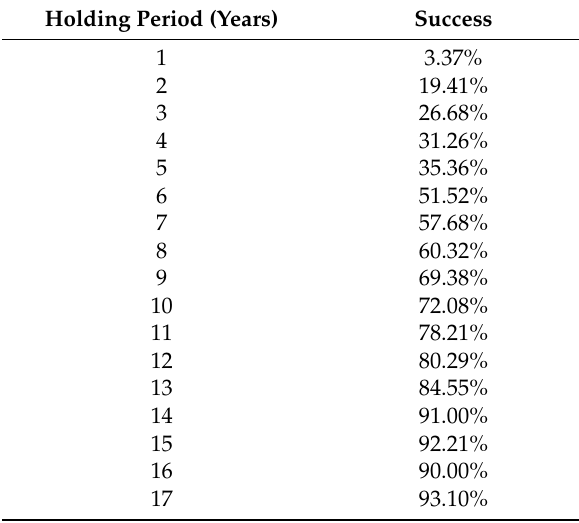
Table 3. Percent of NASDAQ ETF’s that had a 100 Percent Success Rate by Holding Period. Holding Period